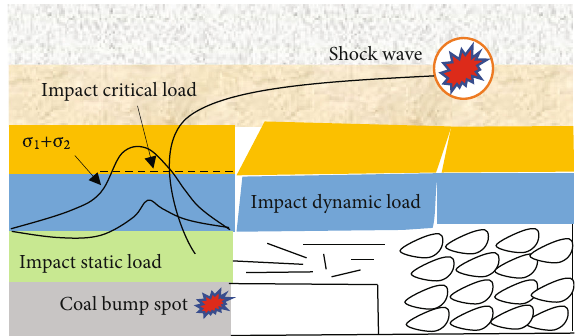
Figure 12: The coal bump model is due to the superposition of dynamic and static loads ( σ respectively, and σ d + σ s represent the superposition of dynamic and static loads stress).